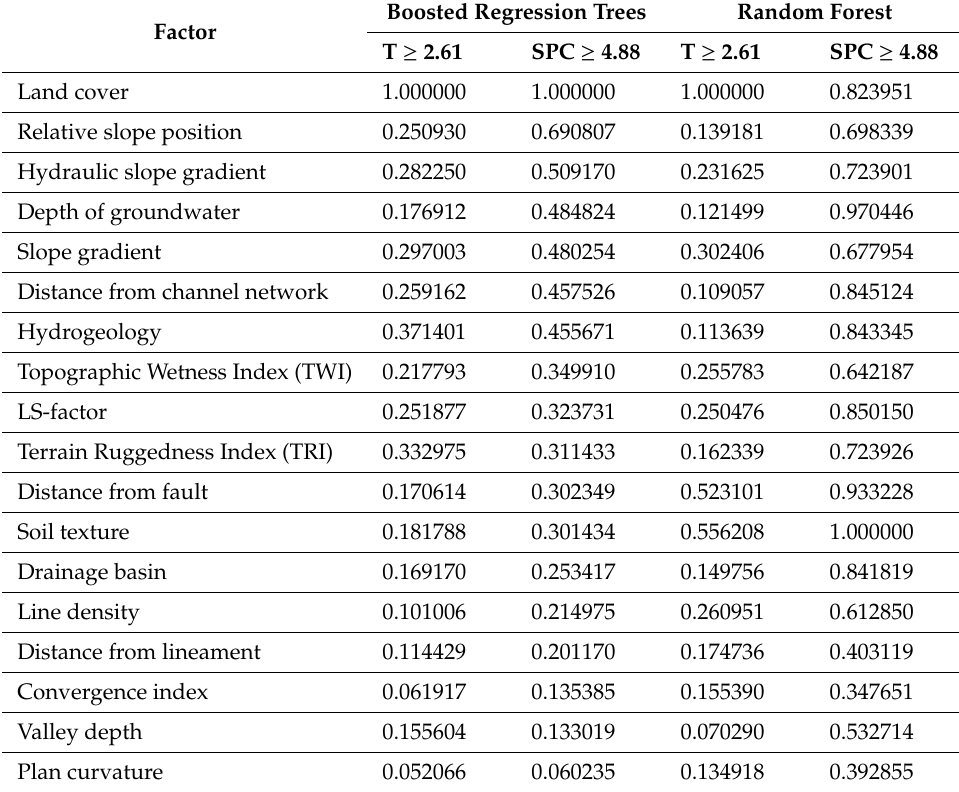
Table4. PredictorofimportancefactoroftheBoostedRegressionTree(BRT),RandomForest(RF)models. Boosted Regression Trees Random Factor